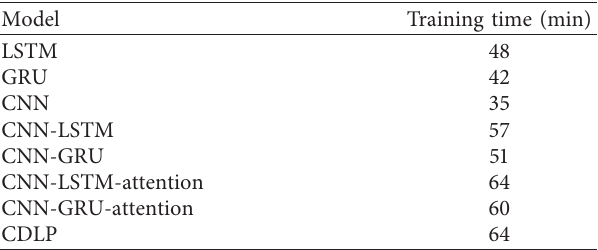
Table 5: Comparison of model training time of CDLP and baseline